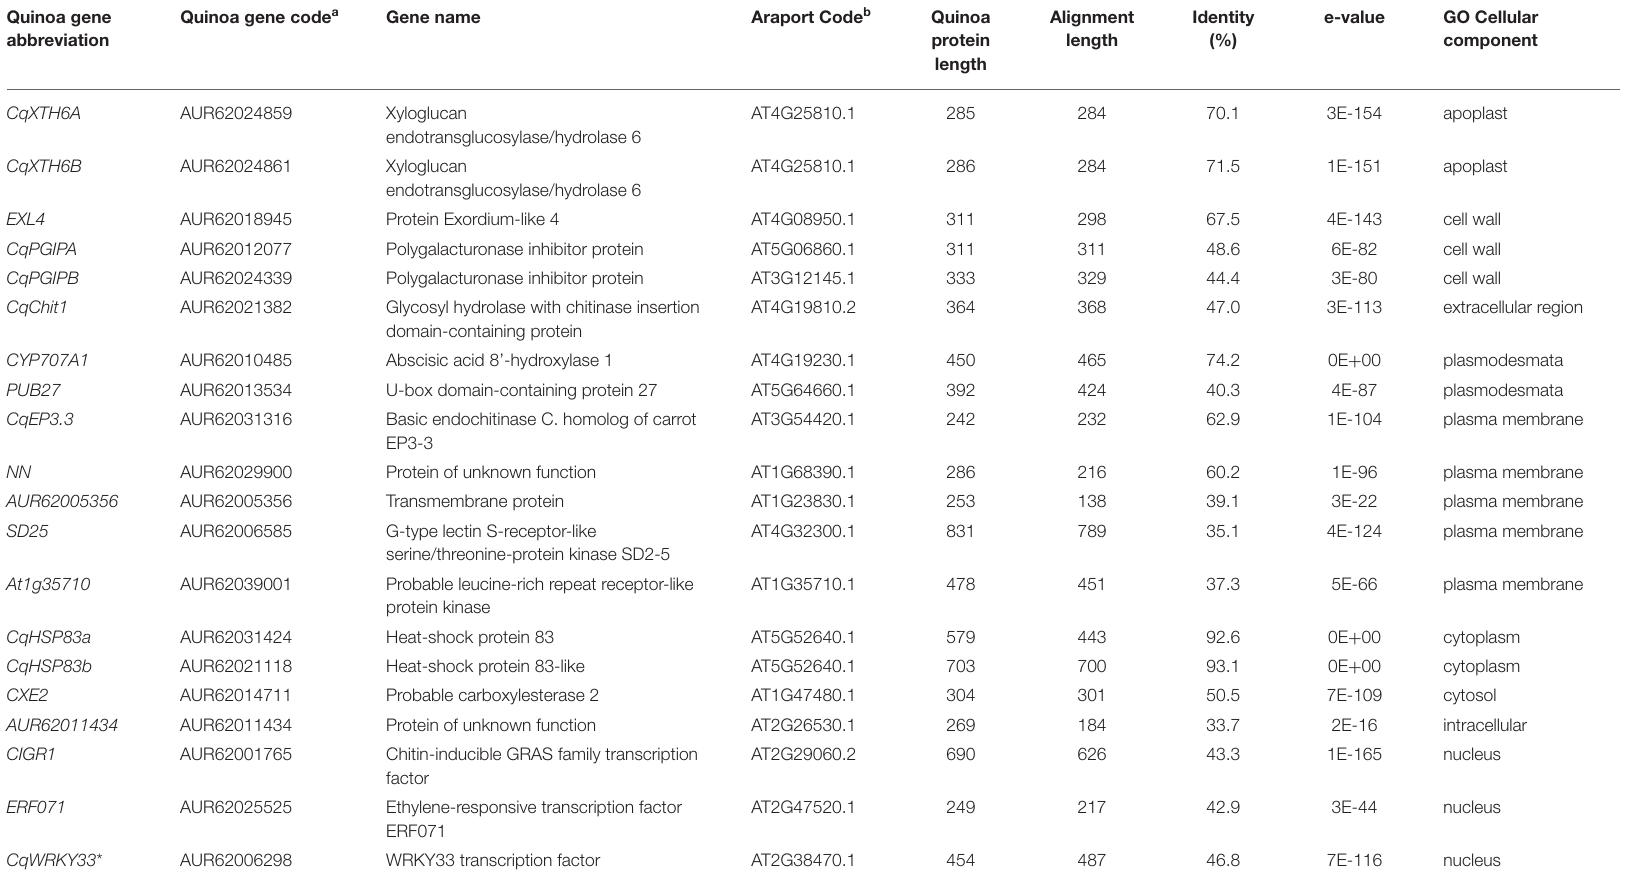
TABLE 3 | Quinoa genes differentially expressed in both Kurmi and Real in response to both Trichoderma